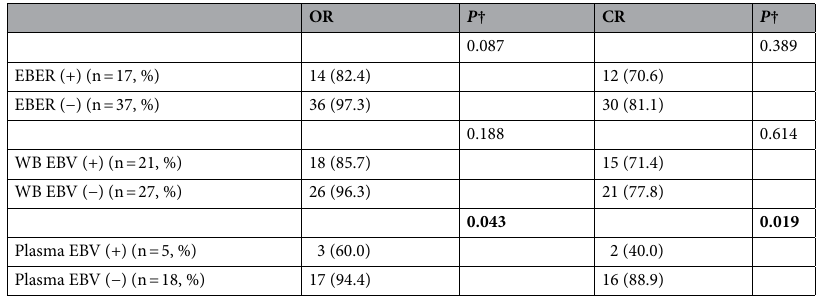
Table 2. Clinical responses according to pre-treatment EBER, whole blood EBV, or plasma EBV status. Significant P values are given in bold. † P values were estimated using the Chi-square or Fisher`s exact test. EBER Epstein-Barr virus-encoded small ribonucleic acids, WB whole blood, EBV Epstein-Barr virus, CR complete response, OR overall